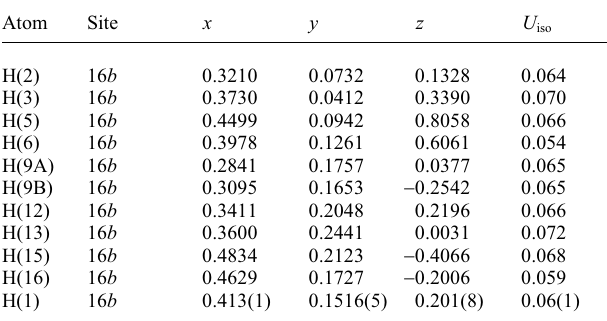
Table 2. Atomic coordinates and displacement parameters (in Å 2 )